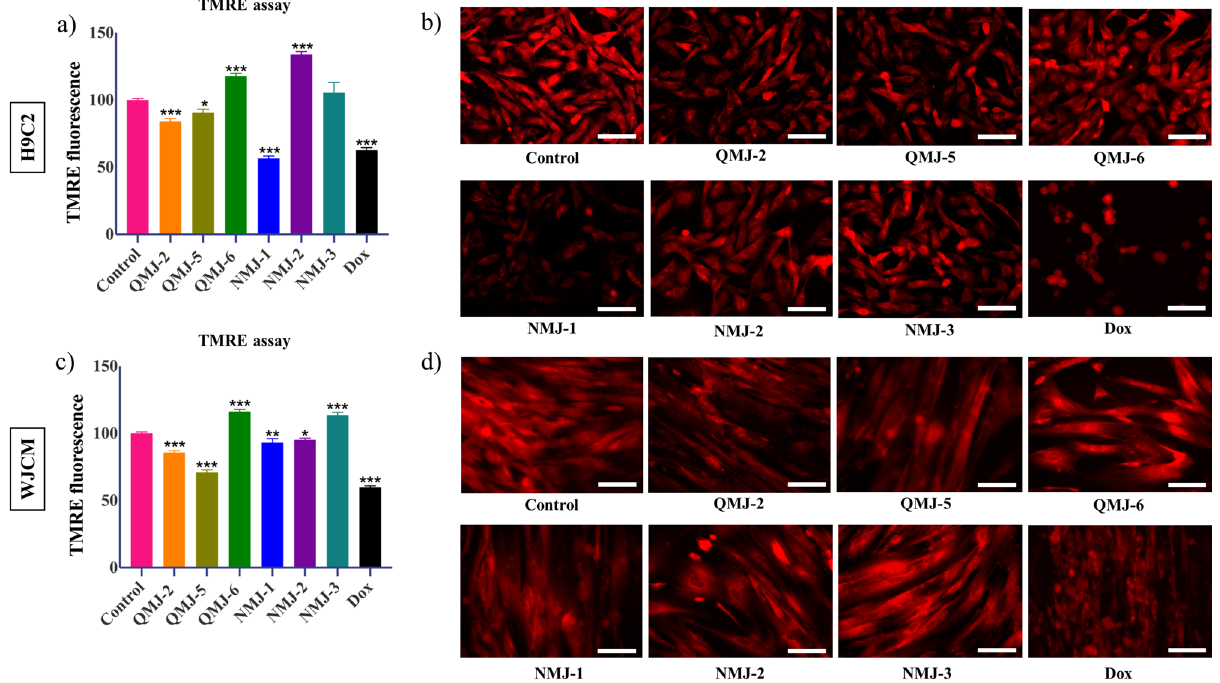
Figure 4. Mitochondrial membrane potential in H9C2 cells and WJCM. ( a , c ) Quantitative measurement of fluorescence intensity of cells stained with TMRE dye after treatment with quercetin or cinnamic acid analogues and ( b , d ) microscopic images of cells captured under a fluorescence microscope. Data represented as mean ± SEM (n = 3), *p < 0.033, **p < 0.002, ***p < 0.001. Scale bar 50 μm. Dox